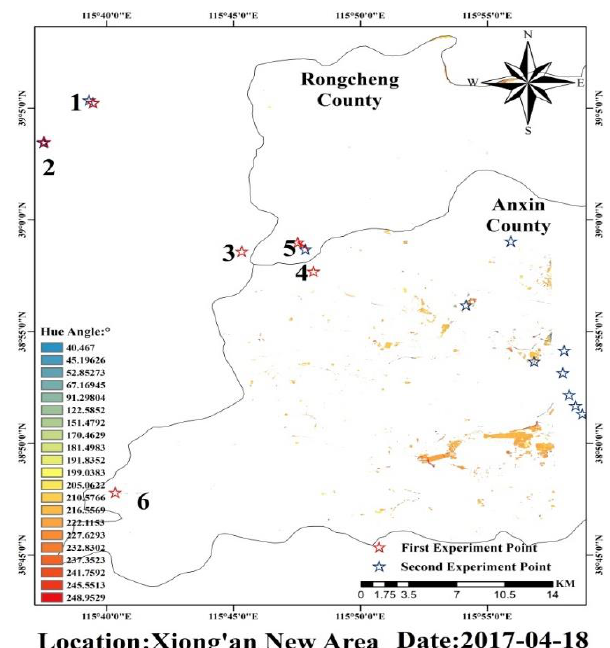
Figure 10. The results of the hue angles of the water bodies in the Xiong’an New Area.